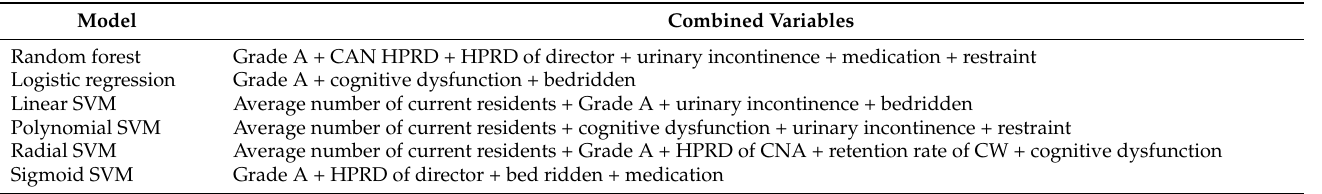
Table 4. Combination of Variables in Prediction